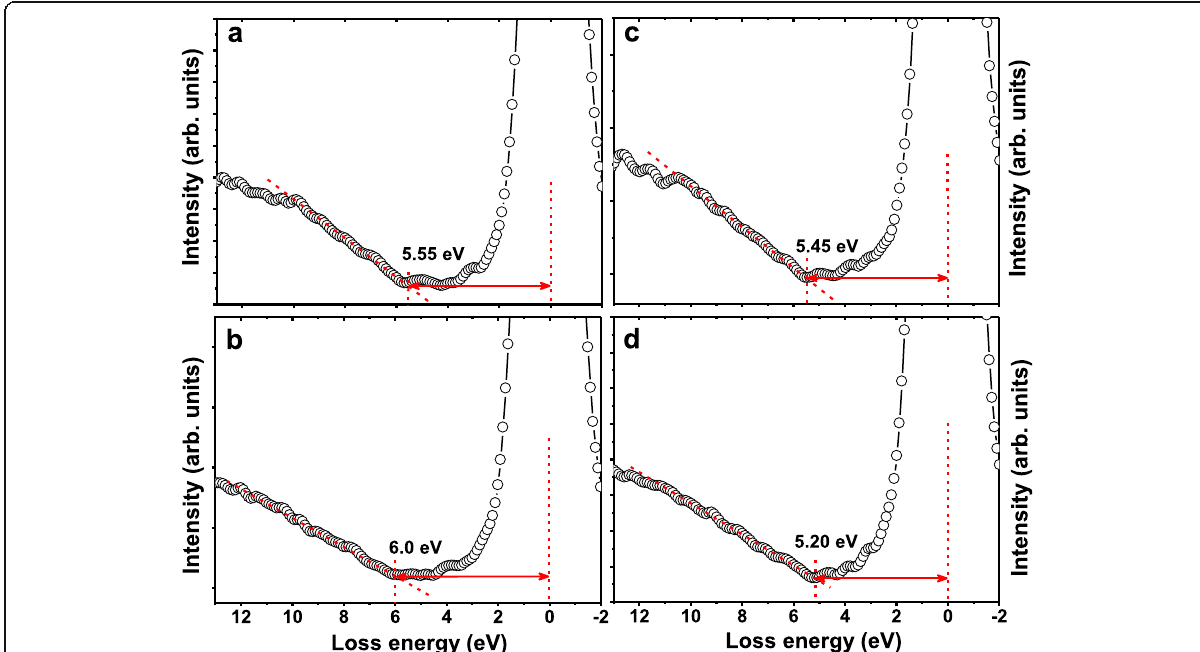
Fig. 3 Bandgaps for the La 2 O 3 films with different thickness and annealing temperatures. a as-grown 10 and b 10 nm La 2 O 3 annealed at 600 °C, and c as-grown 20 and d 20 nm La 2 O 3 annealed at 600